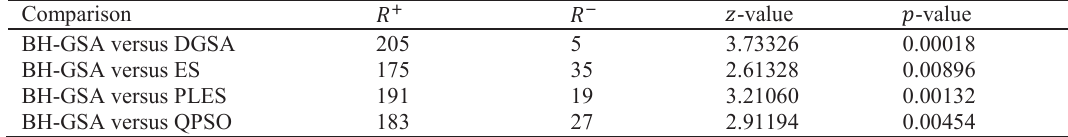
Table 18. Wilcoxon signed ranks test results for multimodal test functions of set 2.